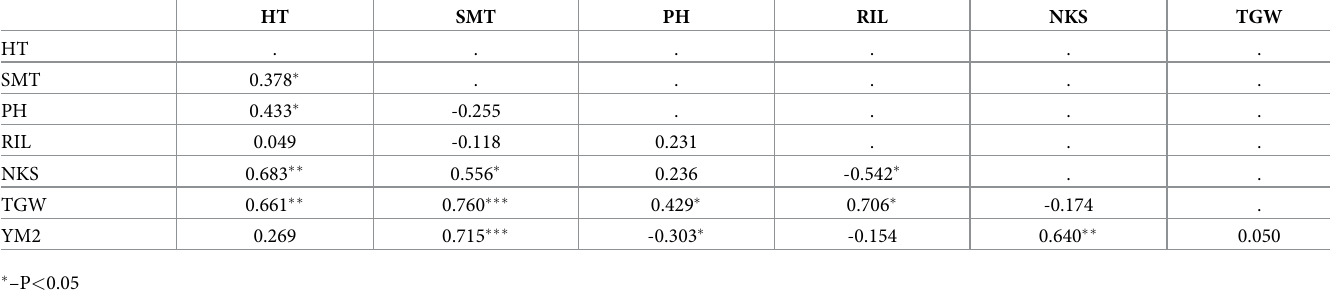
ples for the remaining five locations (S3 Fig). Table 2. Pearson correlation index between traits over eighteen environments using averaged data for lines from six Kazakh and five USA breeding sources. HT SMT PH